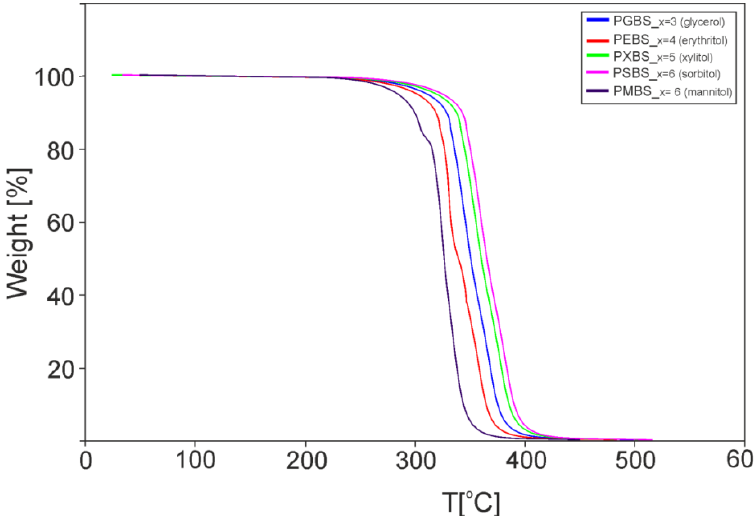
Figure 5. Thermogravimetric analysis (TGA) of the cross-linked samples taken directly after synthesis.